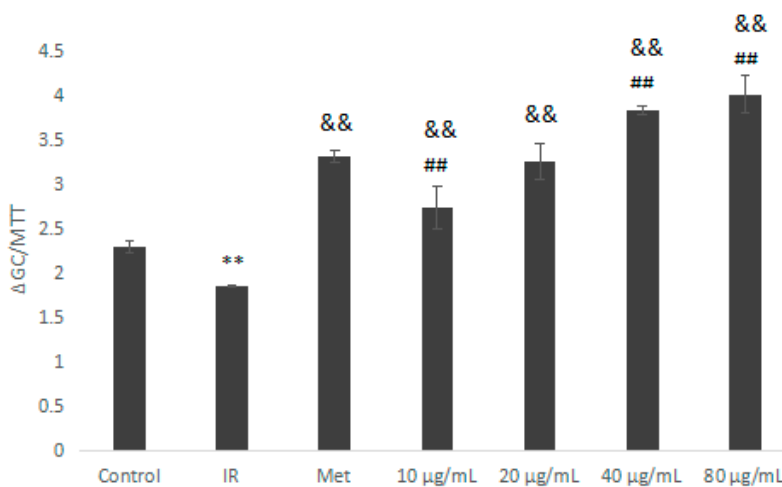
Figure 10. Effect of IOEP2 on the glucose consumption of IR HepG2 cells. IR compared with the control, ** p < 0.01; compared with IR, && p < 0.01; compared with the Met group, ## p < 0.01.